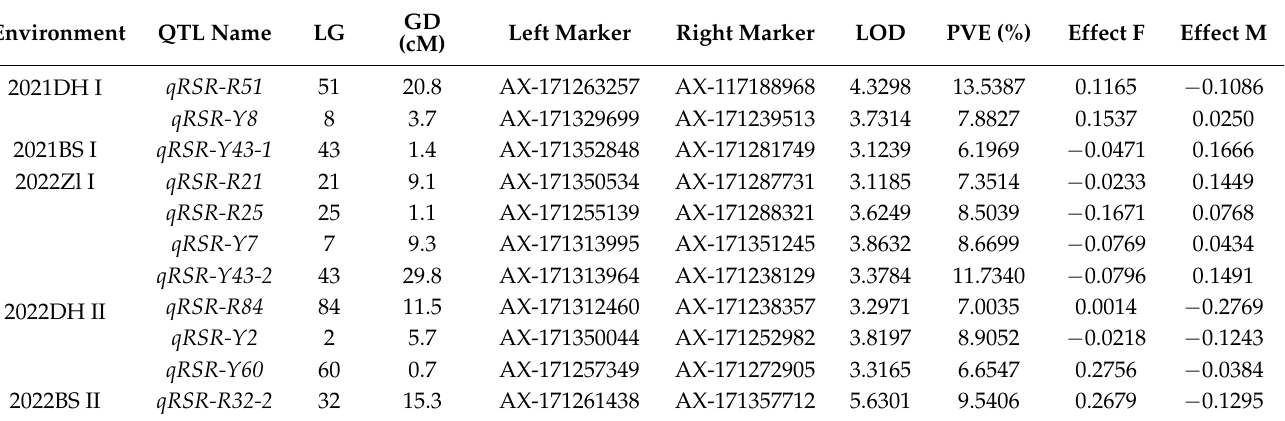
Table 3. QTLs for the ratoon sprouting rate of F 1 population derived from YT93-159 × ROC22 in the ratoon